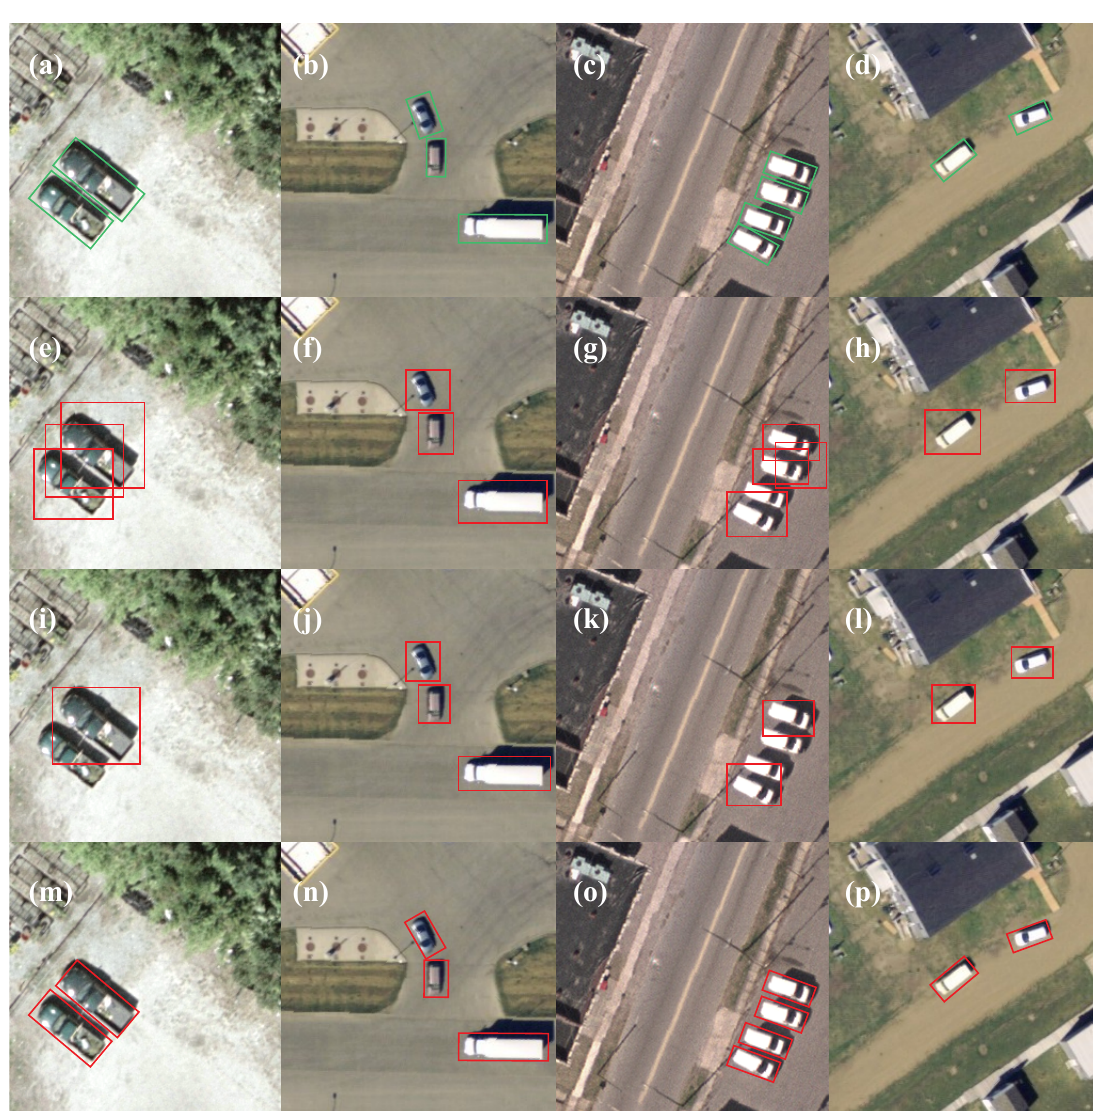
Figure 7. Comparison of the detection results for the OIRDS data set. ( a – d ): The ground truth, ( e – h ): Fast-CNN module, ( i – l ): YOLOv3 module, ( m – p ): Improved YOLOv3